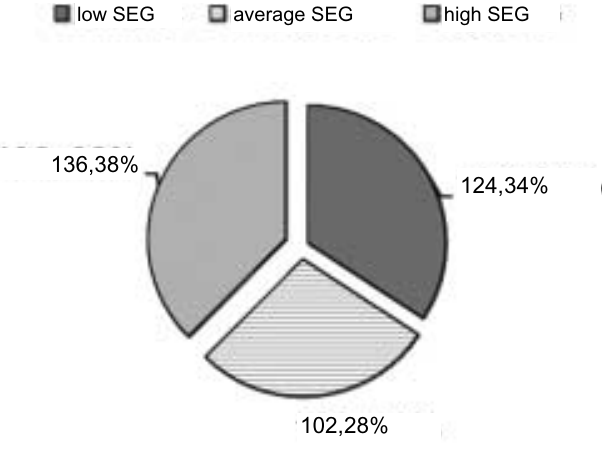
Figure 2. Students who use cell phones to access the Internet off campus by socio-economic